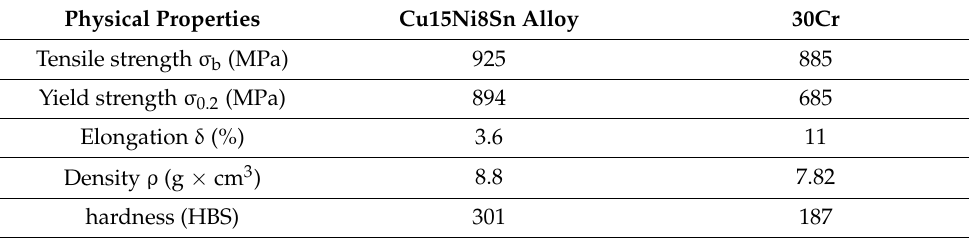
Table 3. Physical properties of friction materials (at room temperature 25 ◦ C).